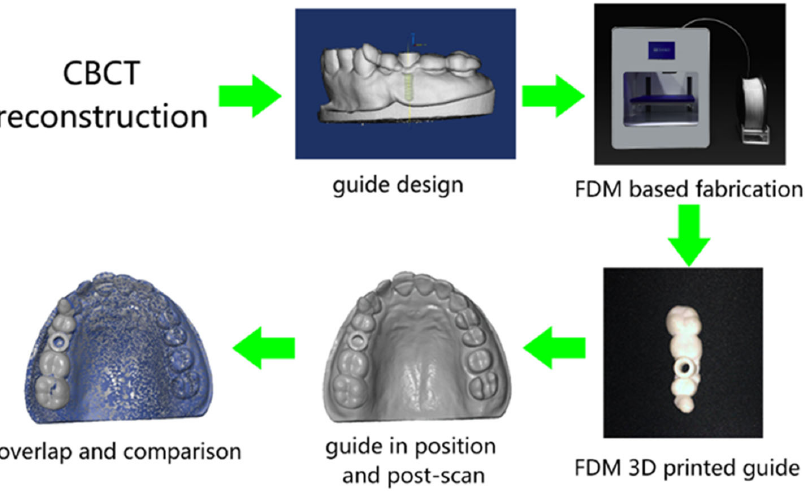
Figure 1. Schematic review of the overall workflow.